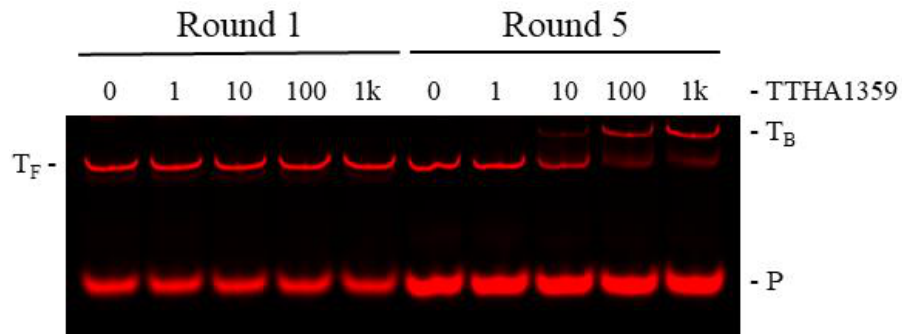
Figure 2. Validation of TTHA1359 REPSA-selected DNAs. PCR-amplified DNA (10 nM)